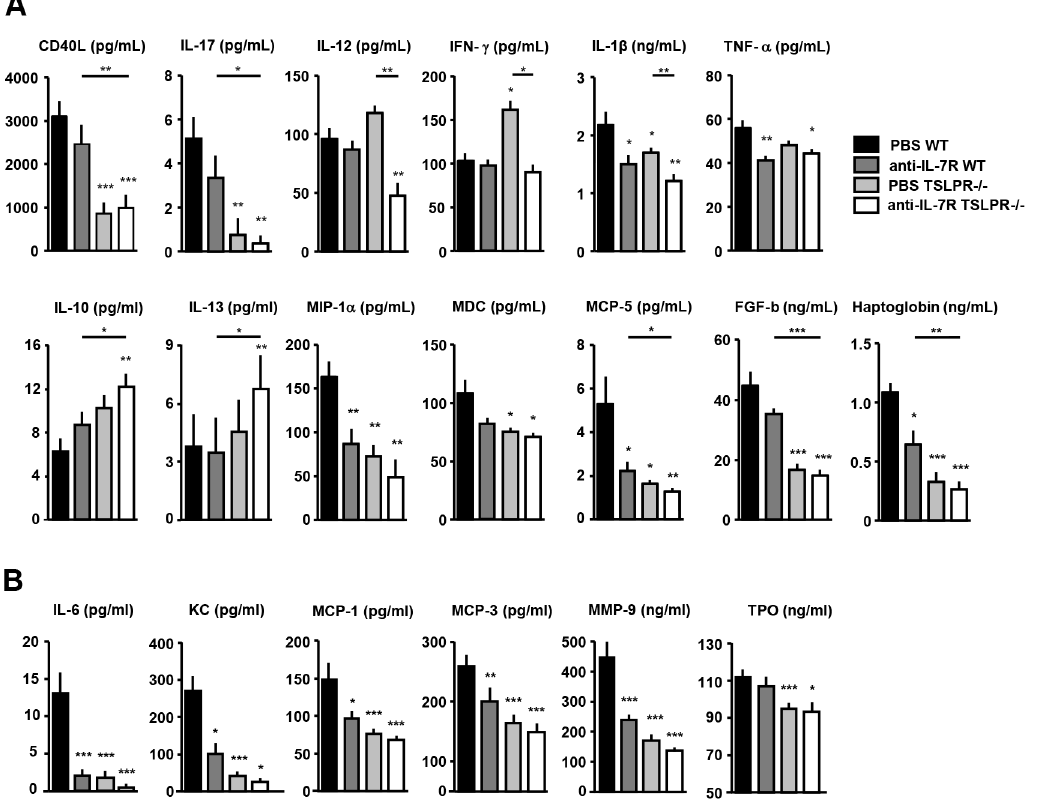
Fig 3. IL-7R blockade and TSLPR-deficiency additively reduce production of pro-inflammatory cytokines, chemokines and mediators involved in tissue destruction and angiogenesis. Cytokine concentrations in paw protein lysates (A) and serum (B) were measured by multicytokine analysis. Cytokines associated with T-cell and monocyte/macrophage activation, chemotaxis, angiogenesis and tissue destruction were reduced by IL-7R blockade and TSLPR deficiency. Values are mean ± SEM of 10 mice per group with representative arthritis scores. * , ** , and *** indicate statistical differences of p < 0.05, p < 0.01, or p < 0.005